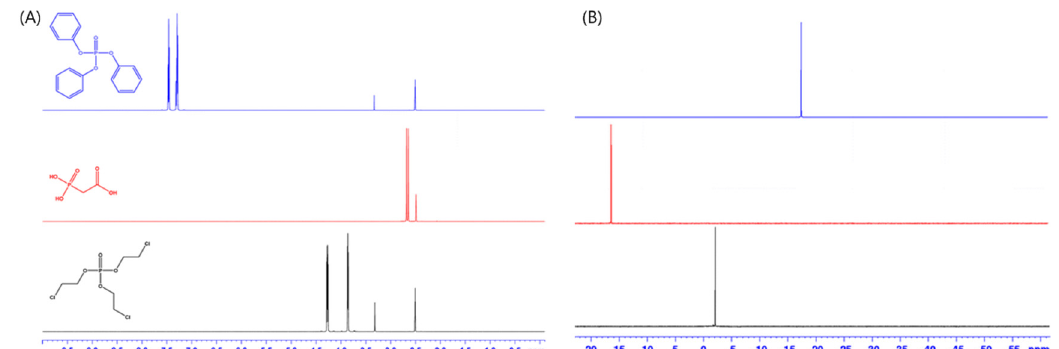
Figure 1. Overlaid ( A ) 1 H NMR and ( B ) 31 P NMR spectra of triphenyl phosphate (blue), phosphonoacetic acid (red), and tris(2-chloroethyl) phosphate (black). Note that the DMSO solvent and residual water signals appear at 2.5 ppm and 3.3 ppm in the 1 H NMR spectra (Adapted with permission from [35], Springer, 2015). NMR = nuclear magnetic resonance.